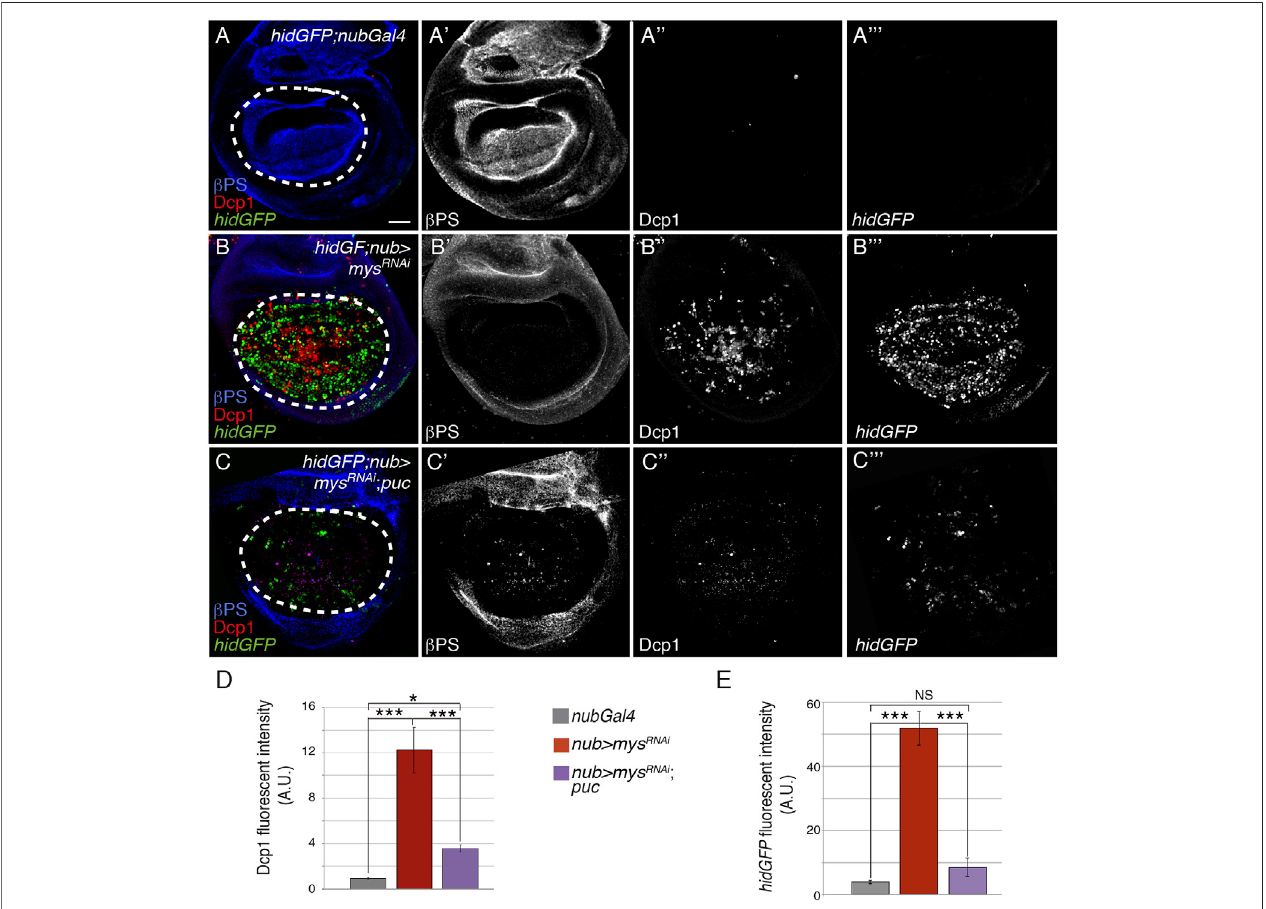
FIGURE 4 | Integrins promote cell survival by inhibiting the JNK pathway. (A – C - ) Maximal projection of confocal views of third-instar wing imaginal discs carrying the reporter hidGFP , stained with anti- β PS [blue in (A – C) , white in (A 9 – C 9 )] , anti-Dcp1 [red in (A – C) , white in (A 99 – C 99 )] and anti-GFP [green in (A – C) , white in (A - – C - )] . (A – A - ) Control hidGFP ; nubGal4 wingdisc. (B – B - ) hidGFP wingdiscexpressinga mys RNAiunderthecontrolof nubGal4 , hidGFP ; nub > mys RNAi . (C – C - ) hidGFP wing discco-expressinga mys RNAiandthenegativeregulatoroftheJNKpathway puc ,underthecontrolof nubGal4hidGFP ; nub > mys RNAi ; puc . (D,E) Quanti fi cation of Dcp1 (D) and hidGFP (E) levels in wing discs of the indicated genotypes. The statistical signi fi cance of differences was assessed with a t -test, *** and * p values < 0.001, < 0.01, and < 0.05, respectively. NS, non-statistically signi fi cant. Scale bar in all panels, 30 μ m.